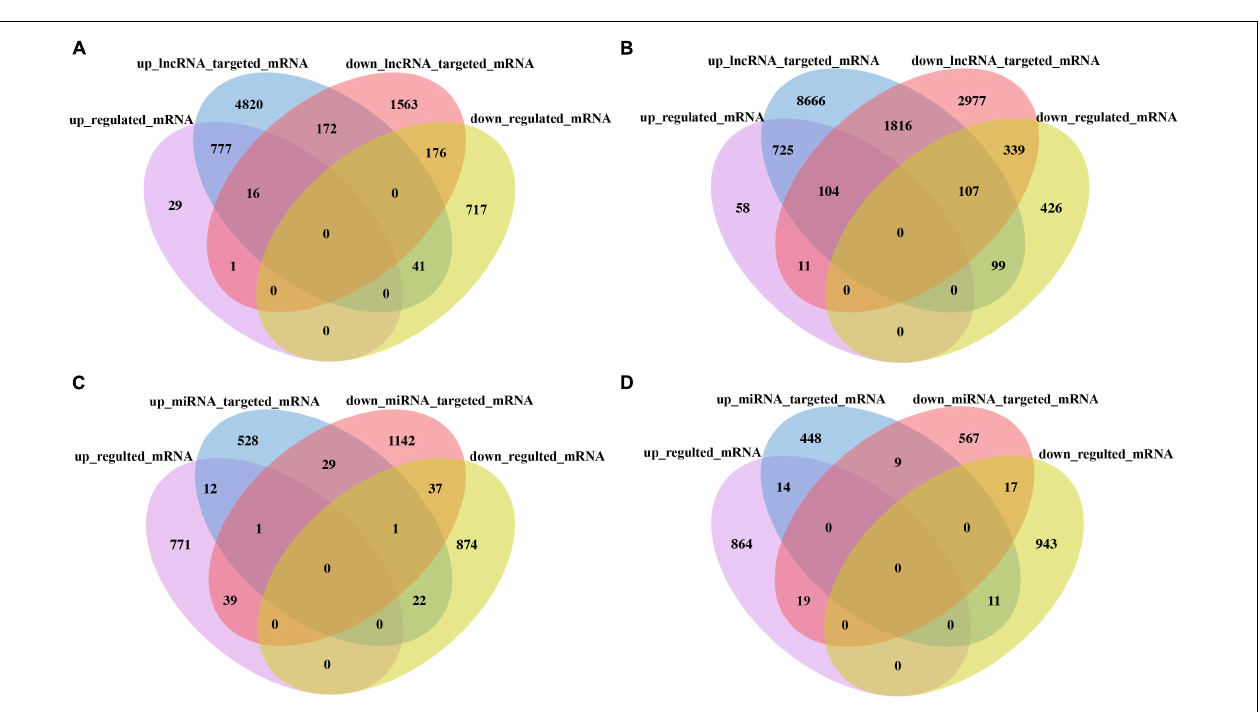
Frontiers in Genetics |